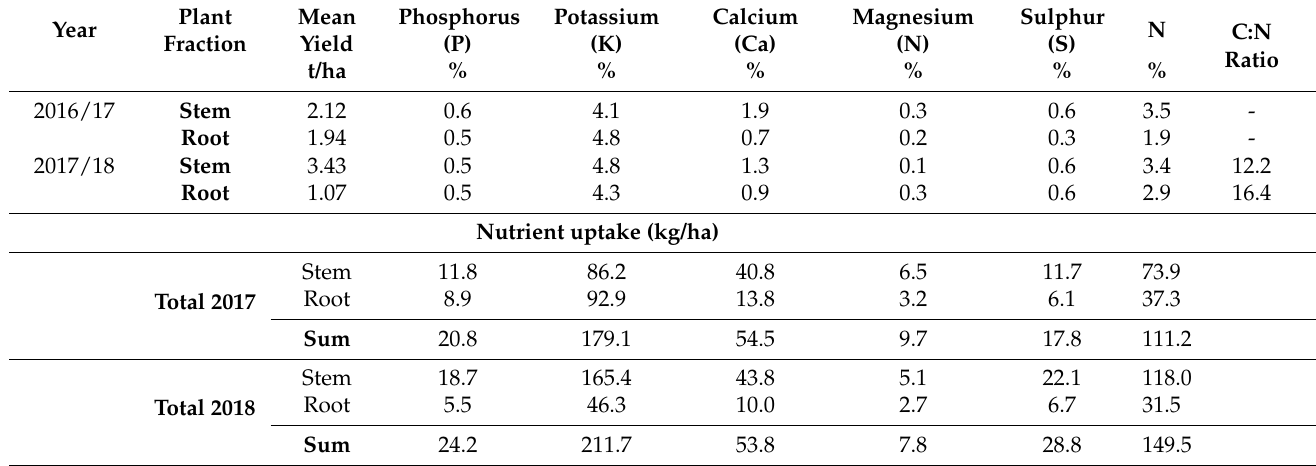
Table 2. Nutrient uptake of the stubble turnip cover crop (kg/ha).